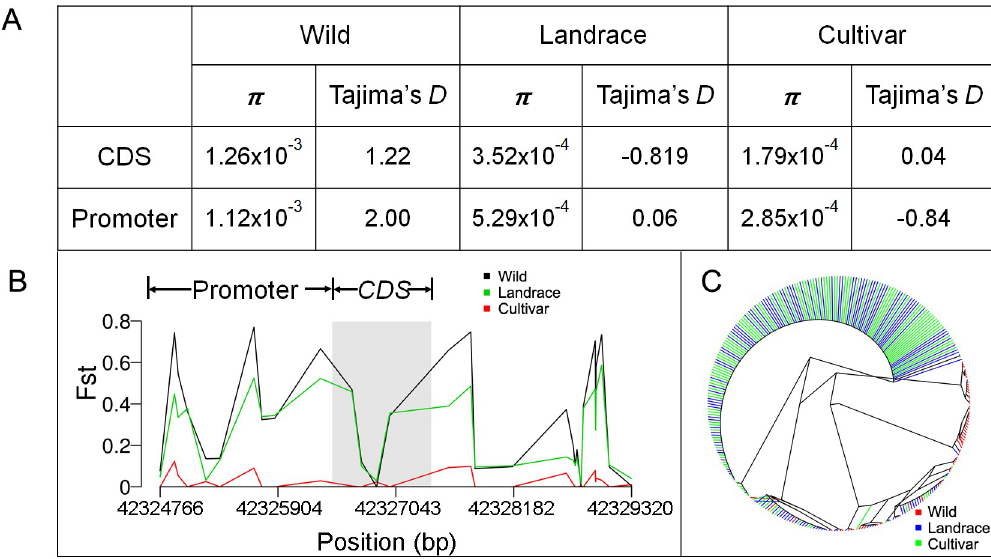
Fig 8. Diversity and evolutionary analyses of GmOLEO1 between wild, landrace and cultivated soybeans. A, Gene diversity ( π ) and Tajima’s D of GmOLEO1 in the three groups. B, Fst in the promoter and coding sequence (CDS) of GmOLEO1 between the three groups. C, A phylogenetic tree comprising the three groups constructed using the SNPs in the promoter and CDS region of GmOLEO1 .